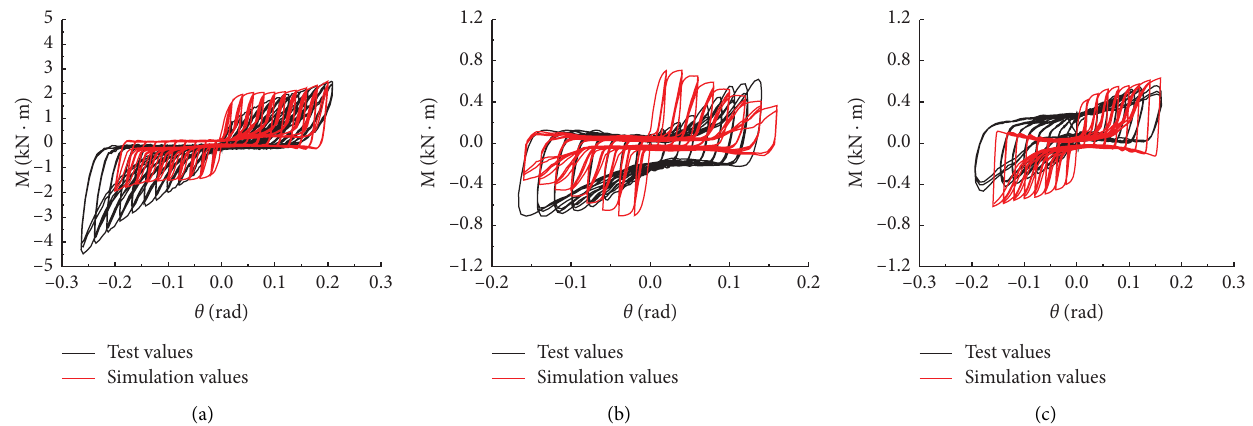
Figure 18: Comparison of moment-rotation hysteretic loops of unreinforced joints: (a) Tou mortise-tenon joints. (b) Ban mortise-tenon joints. (c) Dovetail mortise-tenon